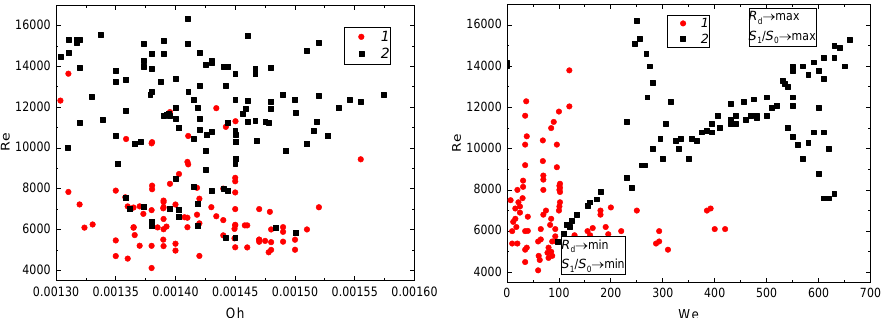
Figure 9. Regime maps of the drop impact as functions of Re(Oh) and Re(We): 1 — deposition of the first drop and coalescence with all others, 2 — breakup.